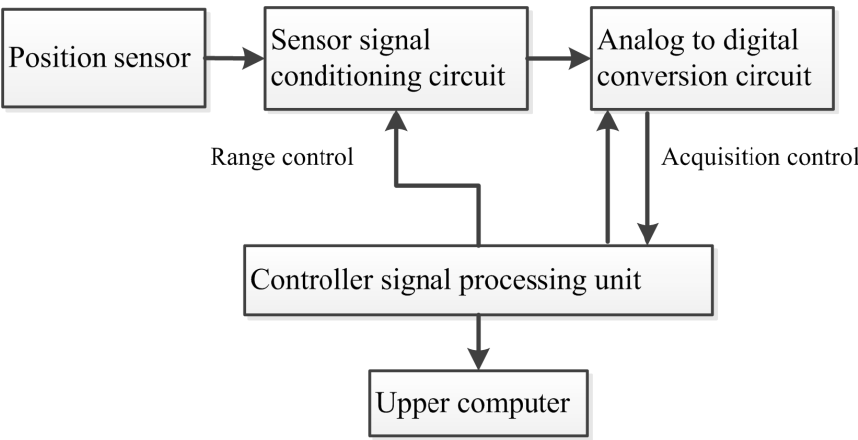
Figure 21. Electrical schematic diagram of micro-displacement sensor.